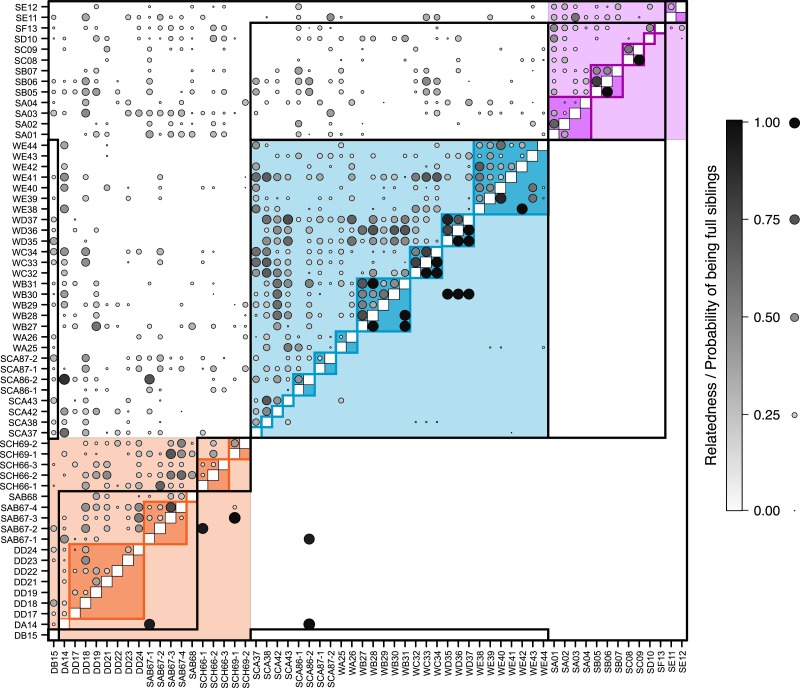
Relatedness and parentage analysis of samples.The pairwise matrix shows the estimated Queller & Goodnight (1989) relatedness of each pair of individuals (excluding those with negative relatedness) above the diagonal, and the probability that each pair are full siblings based on maximum likelihood estimates from Colony (Jones & Wang, 2010) below the diagonal. Comparisons between samples from the same pre-defined population are shaded according to the same colour scheme as Fig. 2 (blue, Răscruci wet, orange, Răscruci dry, purple, Şardu). Individuals sharing the same ant nest are outlined with lines in these same colours, and those sharing the same Myrmica species as host are outlined with black lines. The area and shade of each data point is proportional to the relatedness or probability of being full siblings for that pair of individuals.